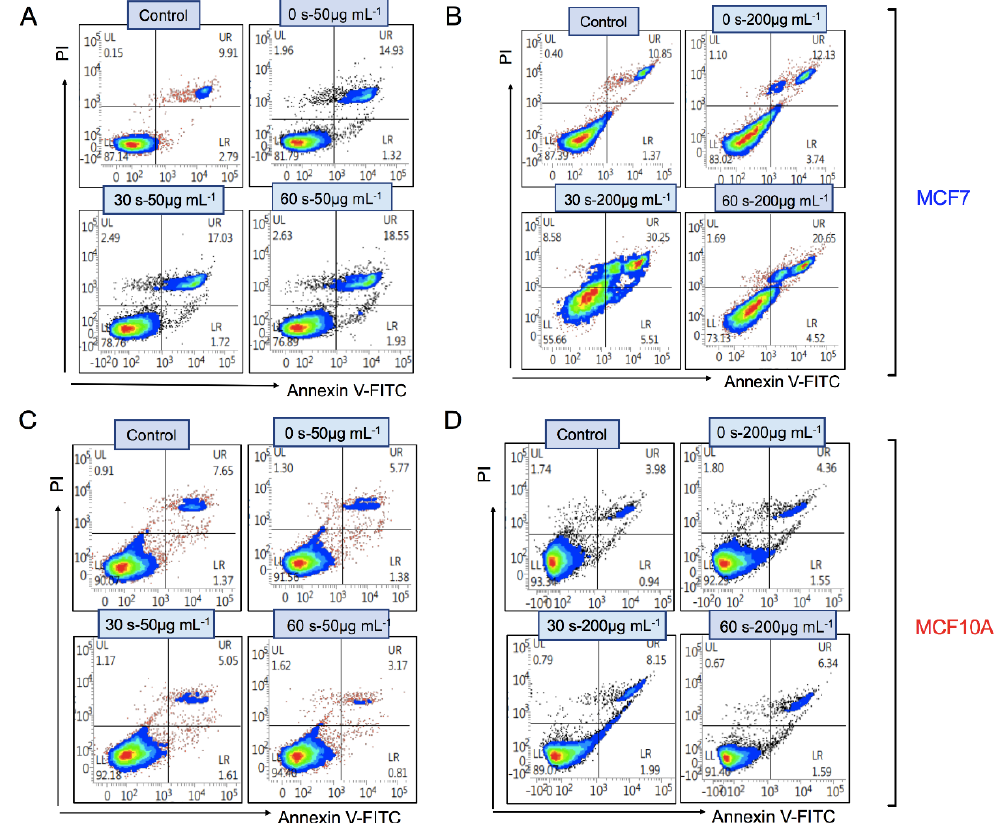
Figure 5. Plasma-treated mushroom-derived extracts stimulate apoptotic cell death in breast cancer cells. ( A – D ) Cell death analysis in MCF7 breast cancer and MCF10A normal mammary epithelial cells.